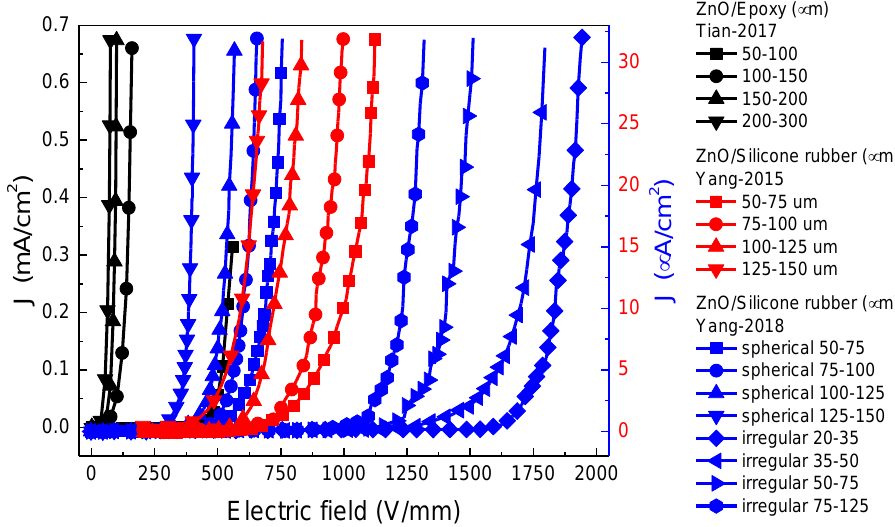
Figure 9. J–E characterization of composites with ZnO as a filler: effects of filler size and morphology. Data extracted from [46,52,54].